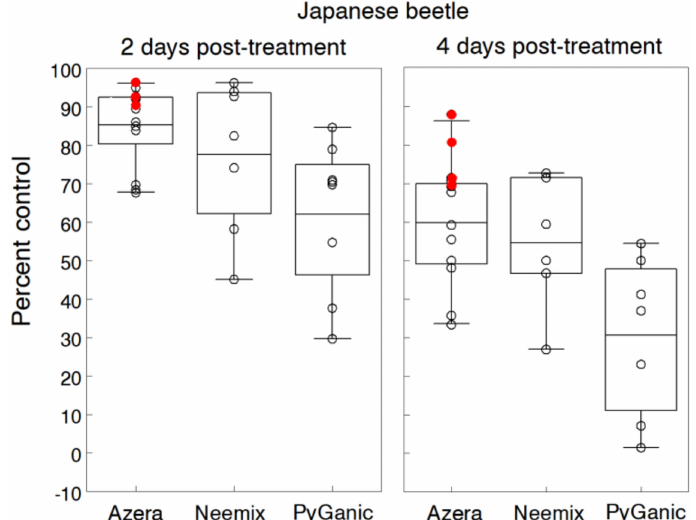
Figure 6. Percent control of Japanese beetles with a single application of Azera, Neemix and PyGanic relative to the untreated control. Mean data at two and four days post-treatment are given for five trials on basil and three trials on marigold flowers. Box-whisker plots show the 25% and 75% percentile range of percent control data and the horizontal line in each box is the overall mean control e ffi cacy. Application rates of Azera, Neemix, PyGanic and Entrust were 2.34 L / h, 1169 mL / h, 2.34 L.h − 1 and 71.2 g a.i. / h respectively, except for trial data in red indicating a higher rate. There were no significant di ff erences among